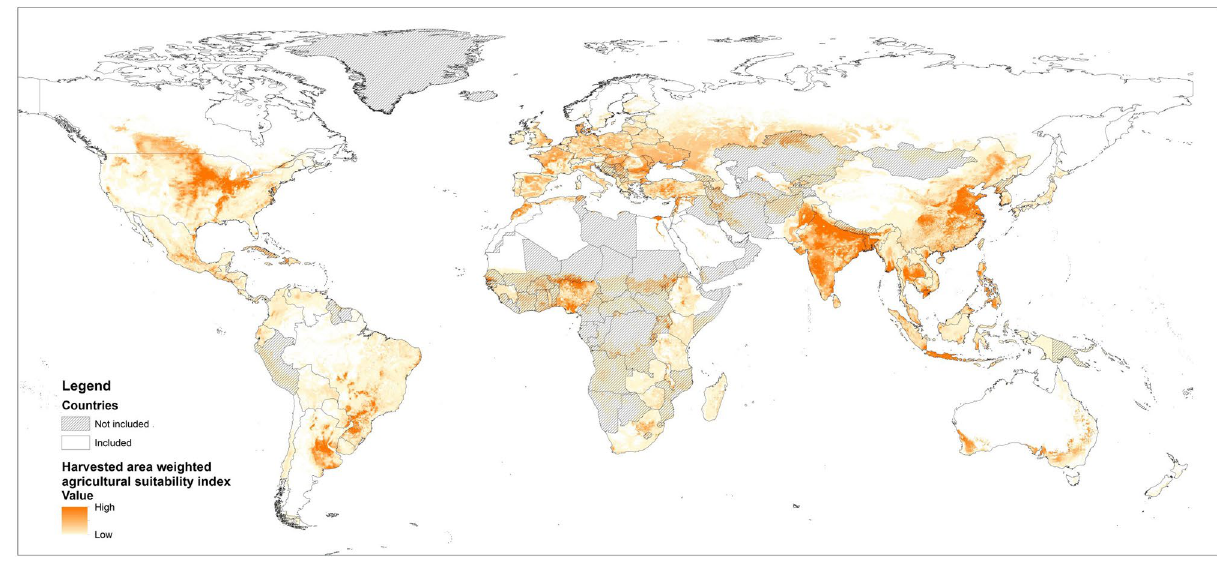
Figure 3. Global map of the harvested area weighted agricultural suitability index on cropland of the 15 selected crops (based on 14,44 ). Countries included in the analysis are marked white, countries excluded (no reported crop-specific nitrogen use) are dashed. Figure was created in ArcMap (version 10.7, https:// deskt op. arcgis. com/ en/ arcmap/) based on 14,44,58